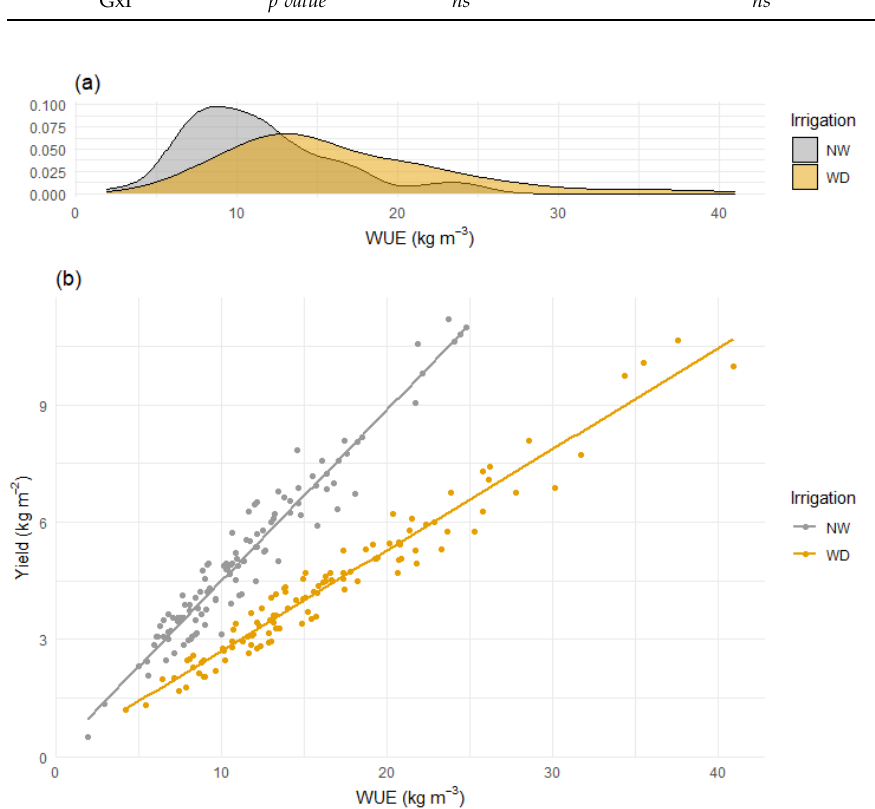
Figure 2. Effect of irrigation regime on water use efficiency in LSL tomato, in relation to yield. ( a ) Histogram showing the comparison between normal watering (NW) and water deficit (WD) treatments; ( b ) relationship between yield (kg m − 2 ) and water use efficiency (WUE, kg m − 3 ). Results are expressed on a fresh weight (fw) basis.